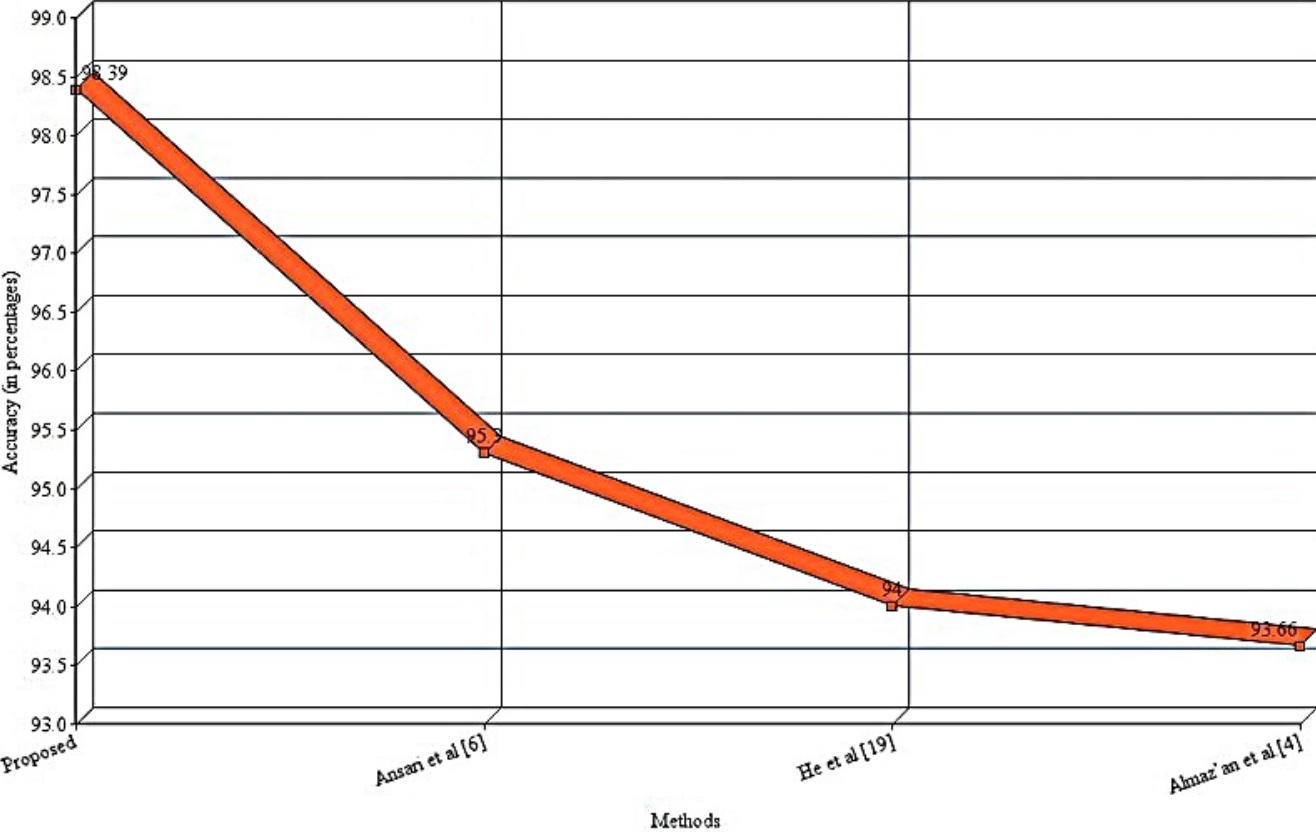
Figure 8. Accuracy (in percentages) of proposed and existing